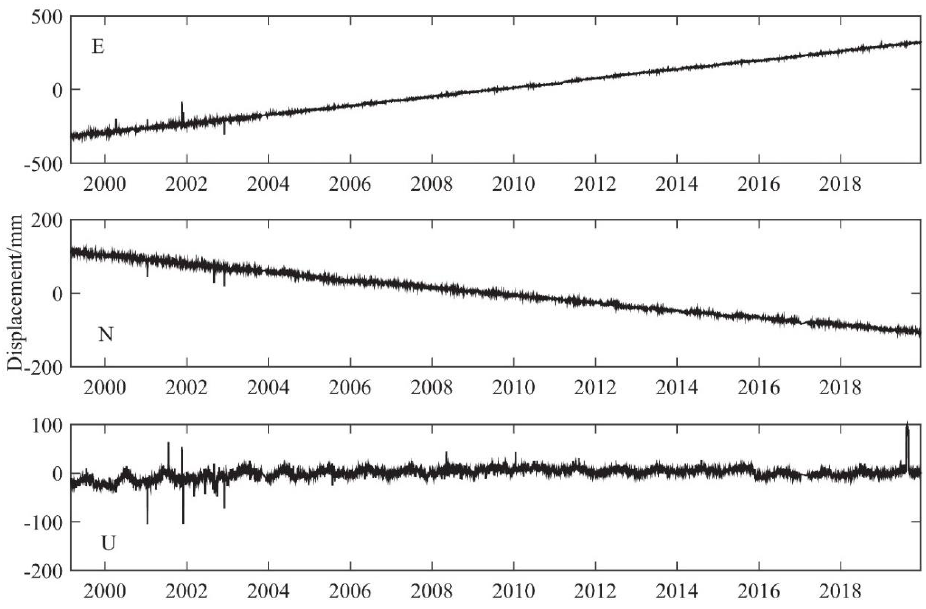
Figure 4. The times series visualization of BJFS GPS station.